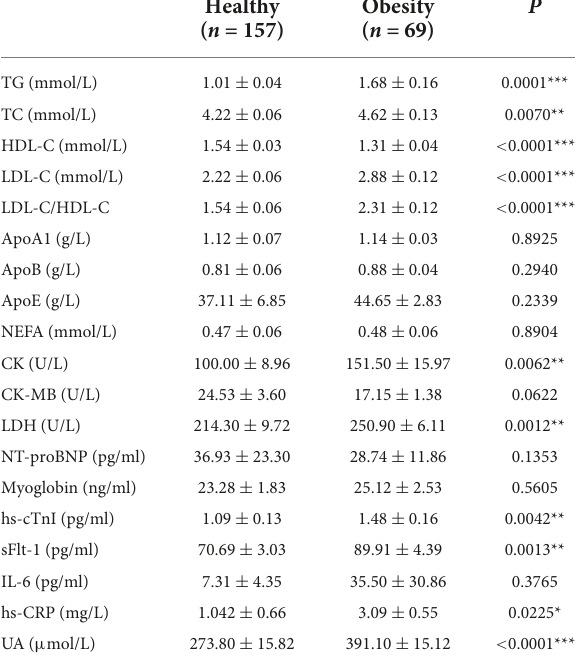
TABLE 5 Biochemistry indicator and cardiovascular risk factors.